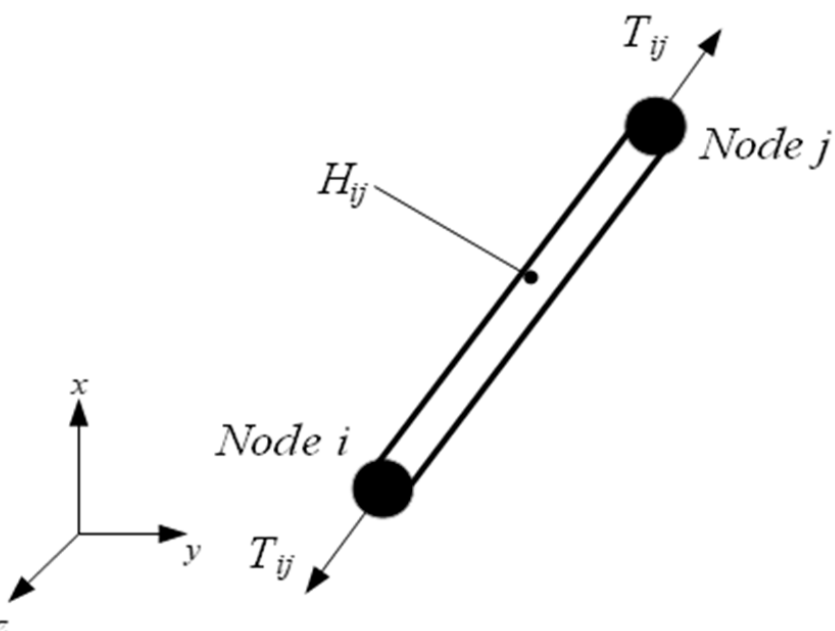
Figure 5. The stress of the truss element.